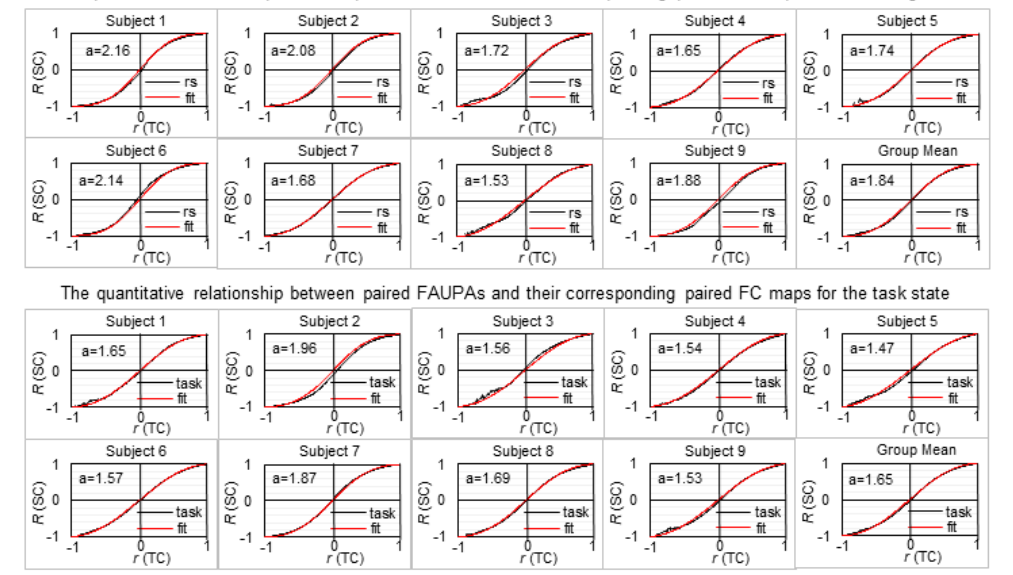
Figure 1. Illustration of the quantitative relationship between brain areal activity and the entire brain’s activity for each brain state of each subject and their group mean as well. The black curve in each plot represents the measured r - R curve and its corresponding red curve represents the best fitted r - R curve using Equation (6) for that brain state of that subject. TC: temporal correlation; SC: spatial correlation; rs: resting state.